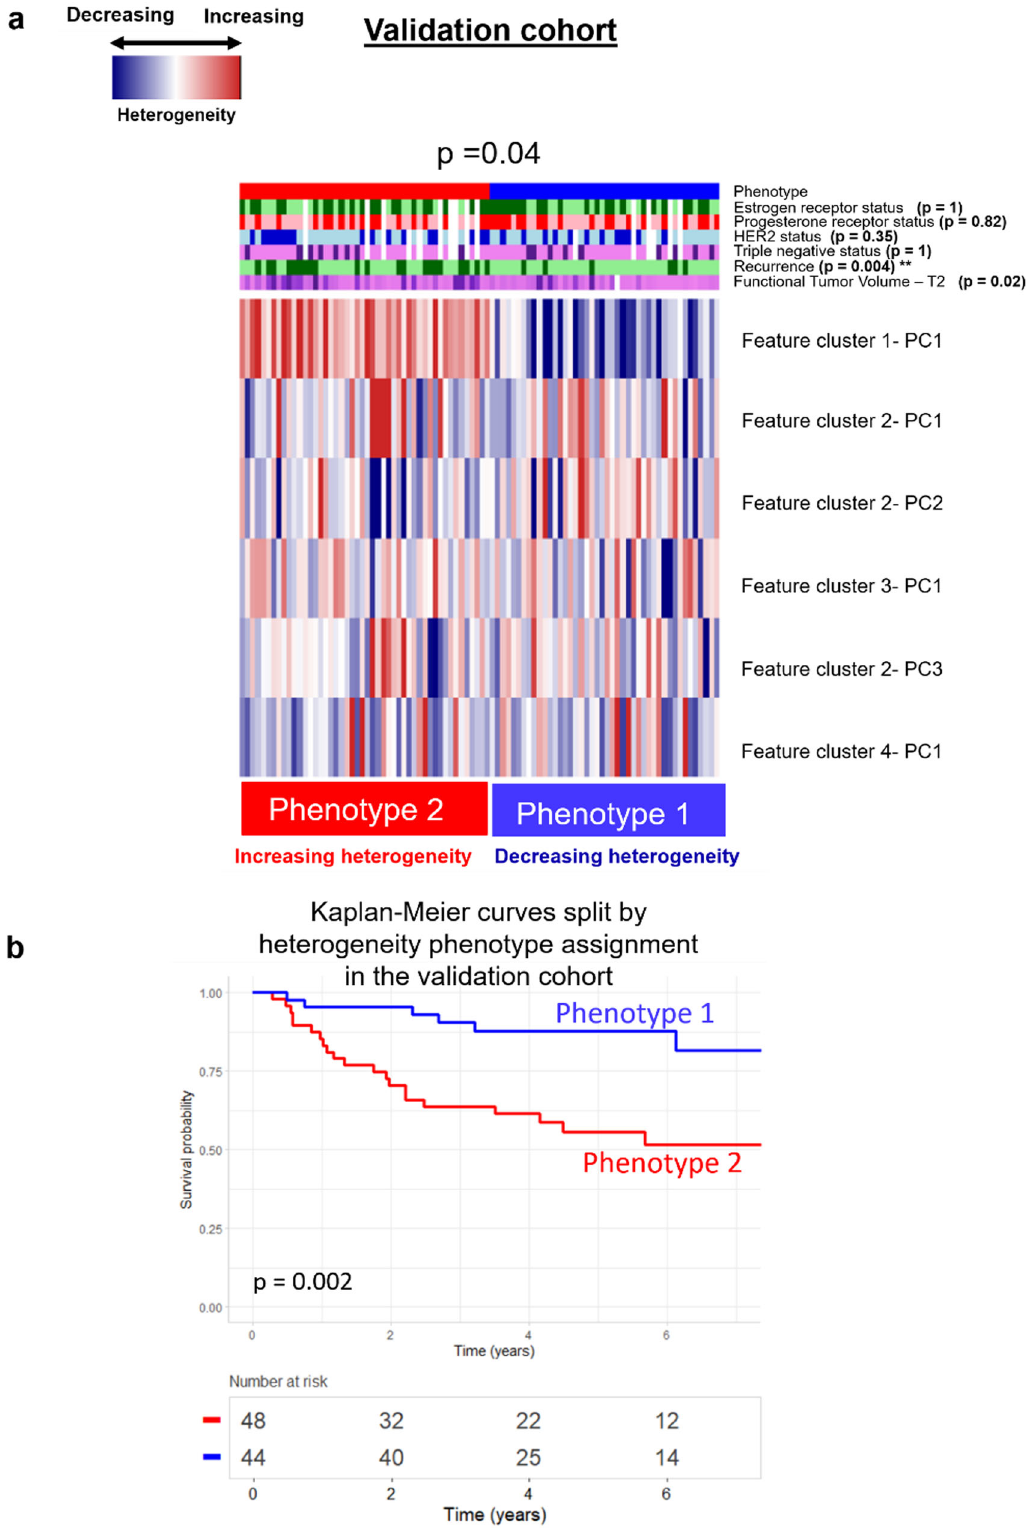
Fig. 6 Replication of Phenotypes in the Validation Cohort. a Replication of radiomics phenotypes in the validation cohort found to be signi fi cant ( p = 0.04). b Kaplan-Meier curves for recurrence free survival (RFS) split on radiomic phenotype show signi fi cant separation ( p = 0.002).